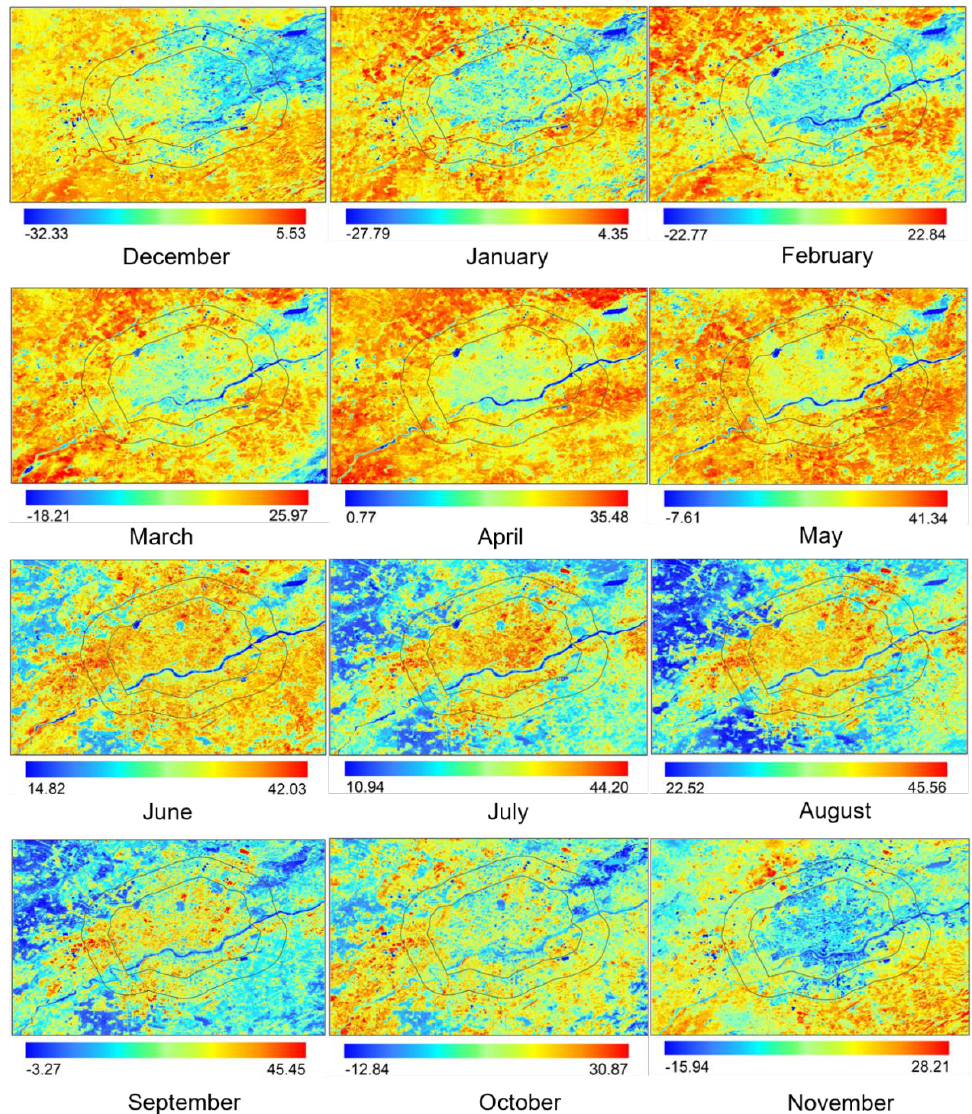
Figure 3. Monthly (instantaneous) land surface temperature variations and the identification of heat/cool island phenomenon from 2018 to 2020.